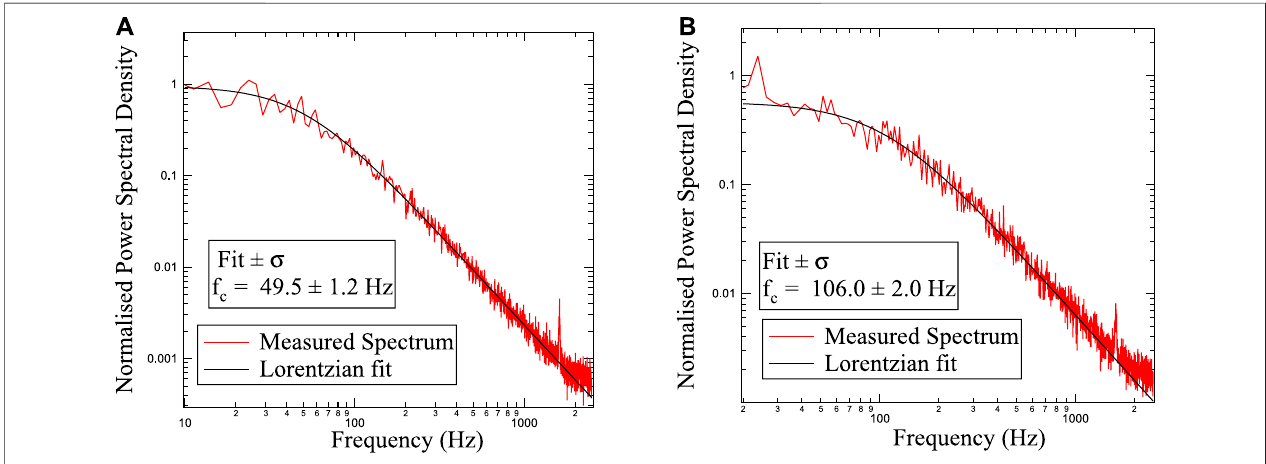
FIGURE 3 | Calibration of the trap by fi tting a Lorentzian to the power spectral data which has been binned over 25 points. The corner frequencies have been obtained for two different powers, 14 and 34 mW, shown respectively in (A) and (B) .